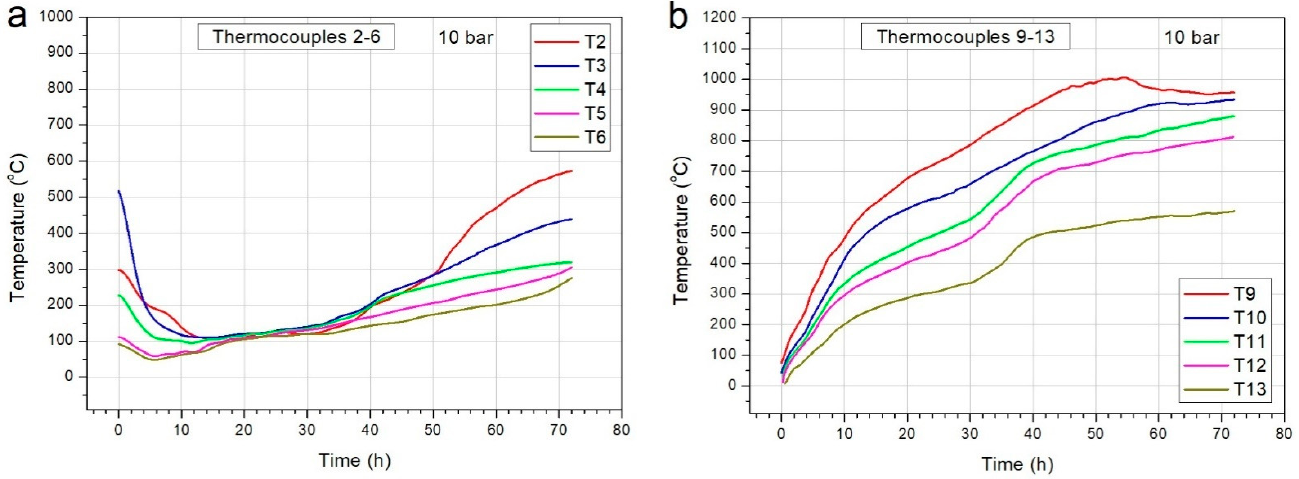
Figure 5. Temperature distribution during gasification of coal under 10 bar pressure. ( a ) Bottom part of the reactor and ( b ) the top part of the reactor.